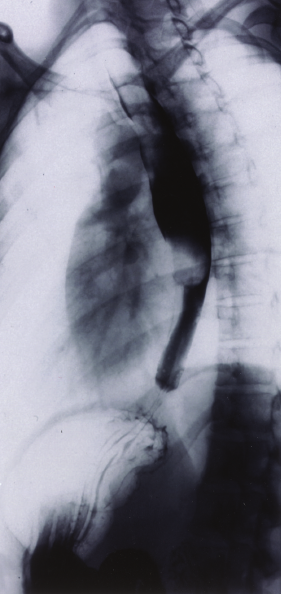
Figure 1: Barium esophagram showing a long pedunculated intraluminal mass from the cricopharyngeus muscle to the level of the inferior pulmonary veins. Unimpeded flow of barium to the stomach was observed.